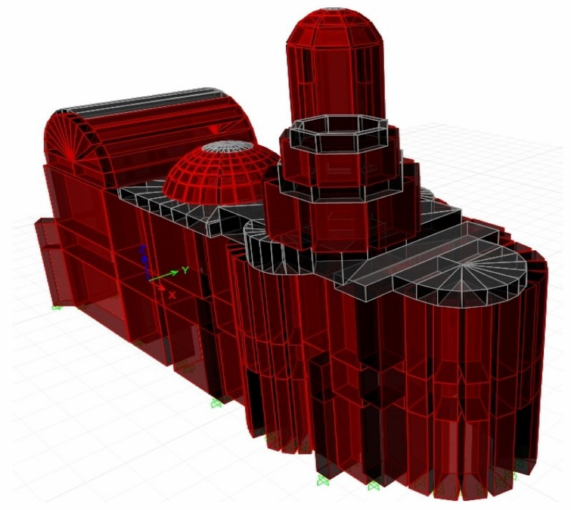
Figure 7. Perspective view—3D model. Shell elements.